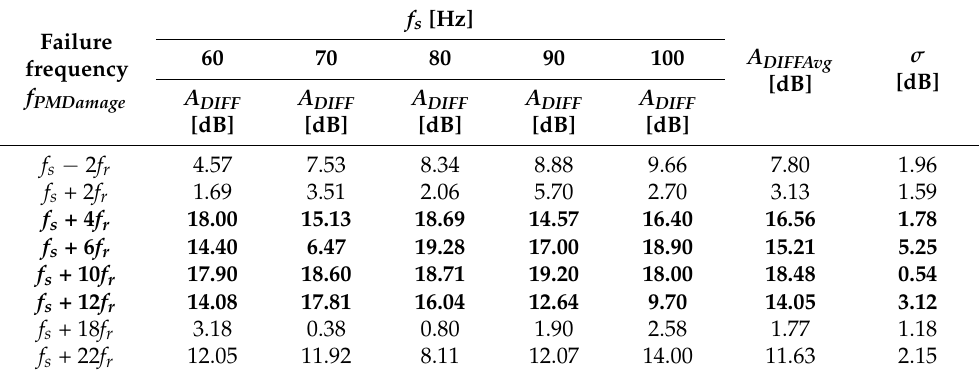
Table 2. The analysis of amplitude increases of the selected frequency components characteristic of the PM fault for different power supply